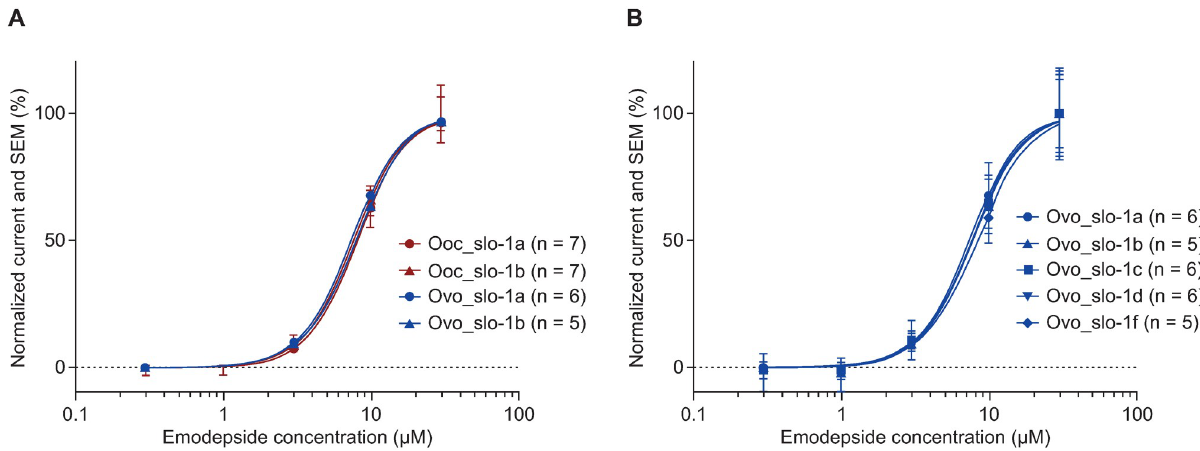
Fig 1. Emodepside sensitivity of Onchocerca ochengi and Onchocerca volvulus SLO-1 splice variants. Onchocerca spp . SLO-1 splice variants were heterologously expressed in X . laevis oocytes to determine species- and splice variant-specific effects of emodepside. All seven SLO-1 splice variants were able to form functional homomeric ion channels and changes in current could be measured with an electrophysiological two-electrode, voltage- clamp approach with oocytes exposed to increasing concentrations of emodepside (0.3, 1, 3, 10 and 30 μ M). For each splice variant at each emodepside concentration, 5–7 oocytes were tested from a single pool of transfected cells to generate biological replicate data; the experiment was performed once. Datapoints are the mean values of the replicates at each emodepside concentration; error bars are standard error of the mean. Normalized concentration–response curves were fitted using the Hill equation. No statistical comparisons were made. Details of the DNA preparation, transfection, voltage clamp procedures and analyses are in the Materials and methods section. A Normalized concentration response curves for the two identified O . ochengi splice variants (red) and their two homologous O . volvulus splice variants a and b (blue). B Normalized concentration response curves for all O . volvulus full-length splice variants a – d , and f . Ooc_, Onchocerca ochengi ; Ovo_, Onchocerca volvulus ; SEM, standard error of the mean.